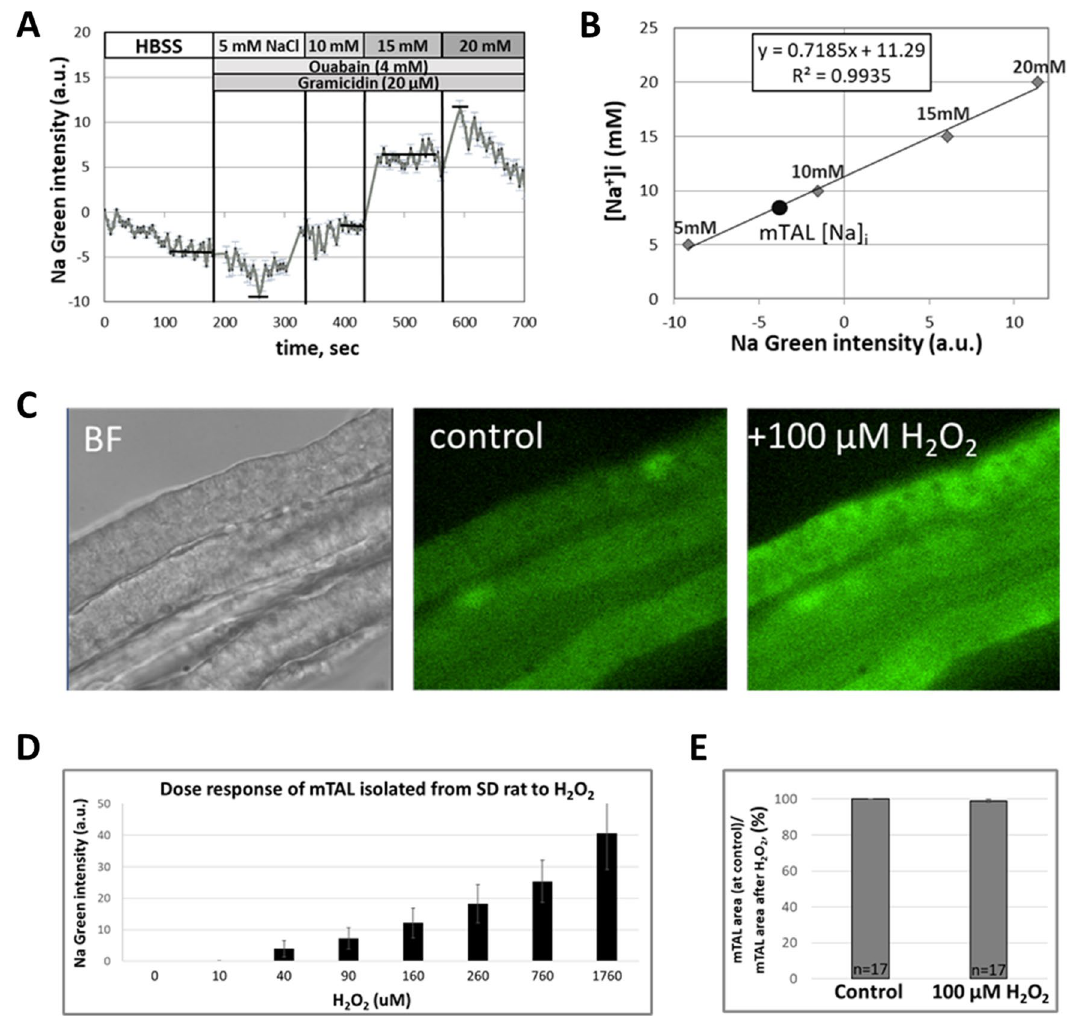
Figure 2. Measurement of intracellular Na + concentrations ([Na + ] i ) in mTAL isolated from SD rats. ( A ) Representative tracings of Sodium Green (Na Green) fluorescence normalized to the first point in mTAL permeabilized with Gramicidin (20 µM) followed by addition to the bath of 5, 10, 15 and 20 mM Na + concentrations to create a standard curve. Ouabain (4 mM) was added with Gramicidin to inhibit Na + - K + -ATPase. ( B ) Representative standard curve of Na Green fluorescence as a function of bath [Na + ] i . ( C ) Representative images of isolated mTAL from SD rat. Left image (BF) : bright field image of mTAL. Center image (control) : mTAL loaded with Na Green dye for 30 min. Right image (+ 100 µM H 2 O 2 ) : response of Na Green loaded mTAL to application of 100 µM H 2 O 2 for 5 min. ( D ) H 2 O 2 dose–response graph (n = 3) measured by Na-Green dye (Na + changes) in mTAL freshly isolated from SD rat. Here is represented the cumulative concentrations of H 2 O 2 . ( E ) Measurements of mTAL area using 3D reconstruction images on confocal microscope before (control) and 2 min after 100 µM H 2 O 2 application (n = 17 mTAL, 3 SD